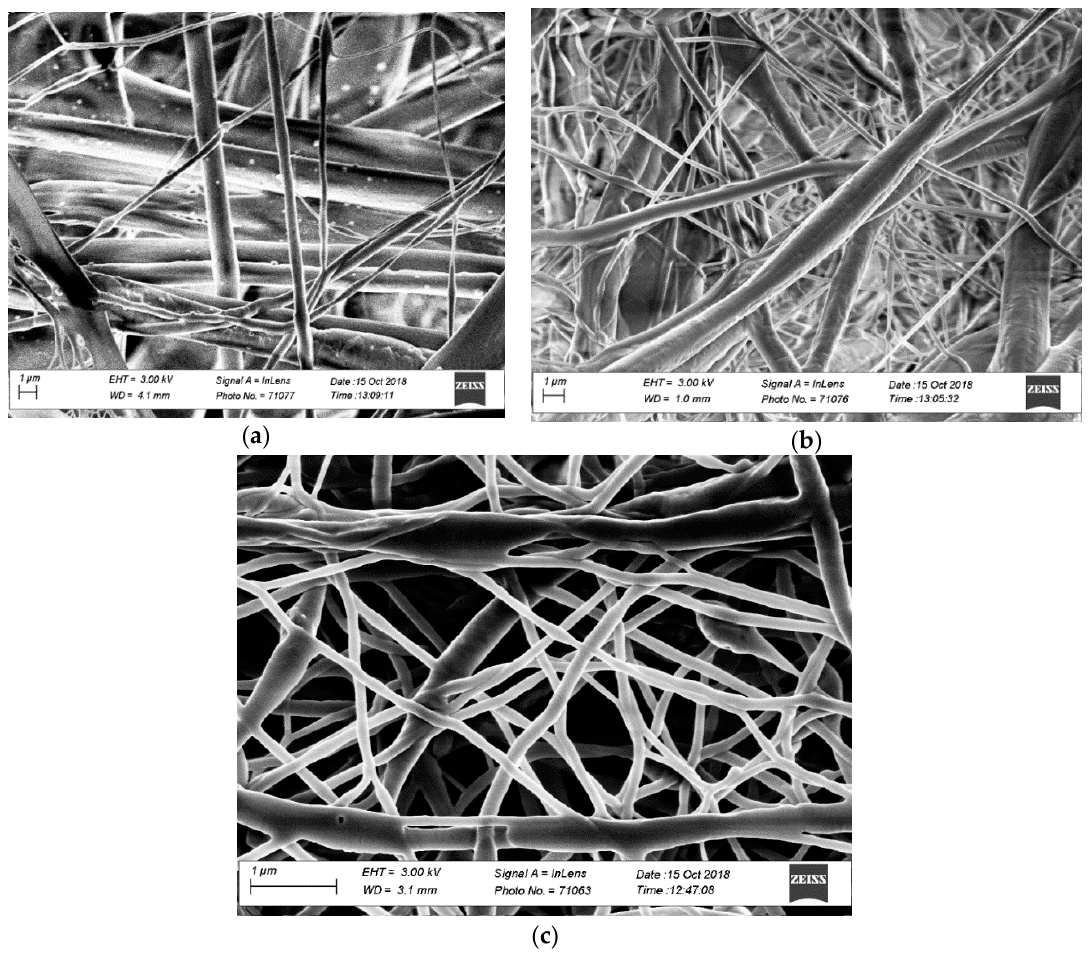
Figure 1. SEM images of electro-spun nanofibrous membranes fabricated from polycaprolactone/cellulose nanofiber (PCL/CNF) copolymer blends at ( v / v ) ratios: ( a ) 80:20, ( b ) 60:40, and ( c ) 50:50.